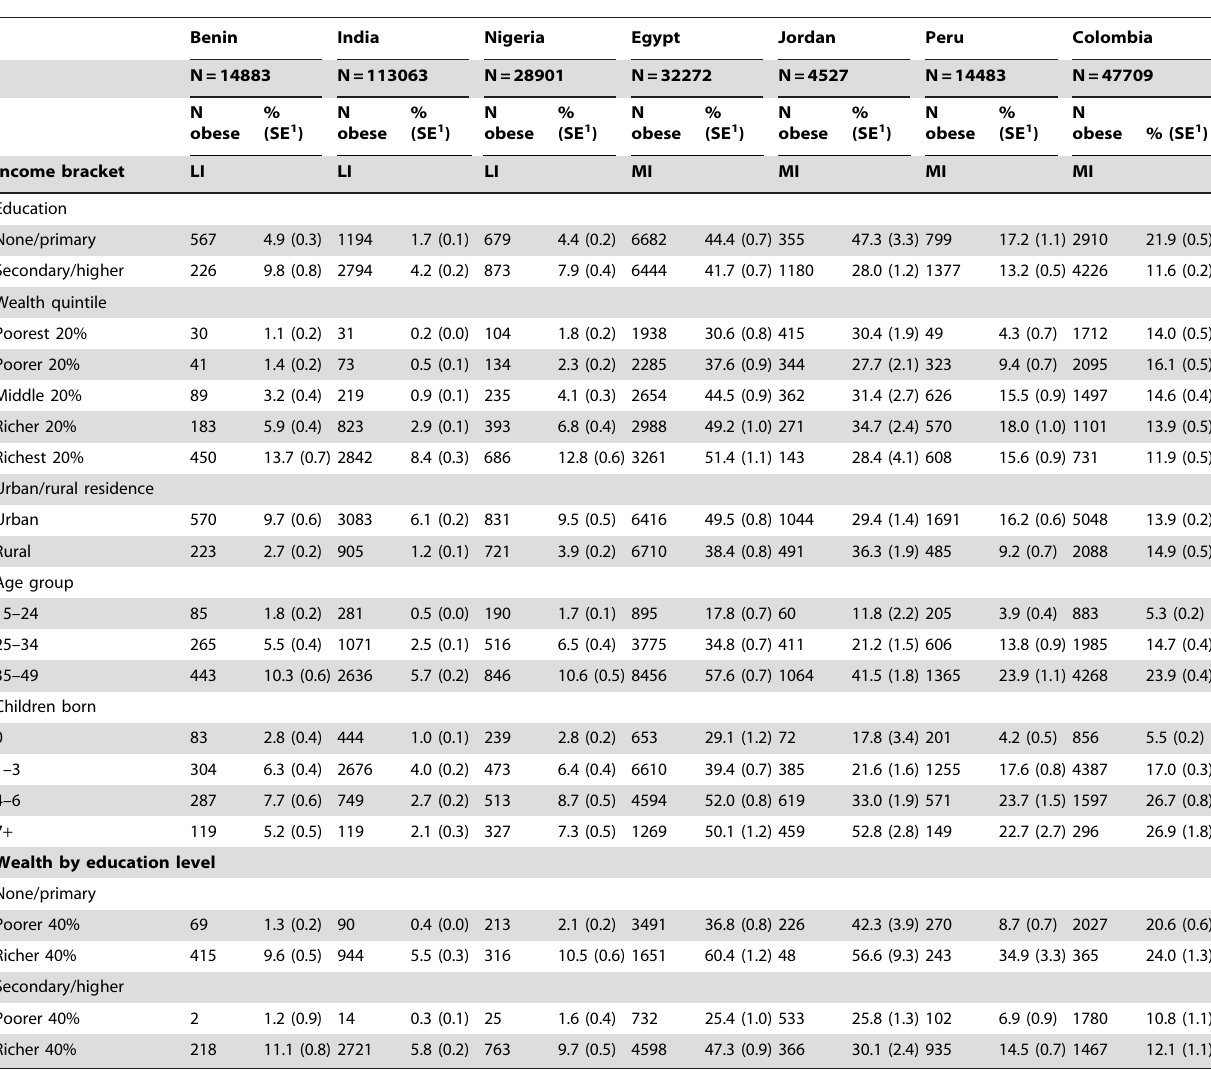
Table 3. Prevalence of obesity by sociodemographic characteristic in each country, DHS